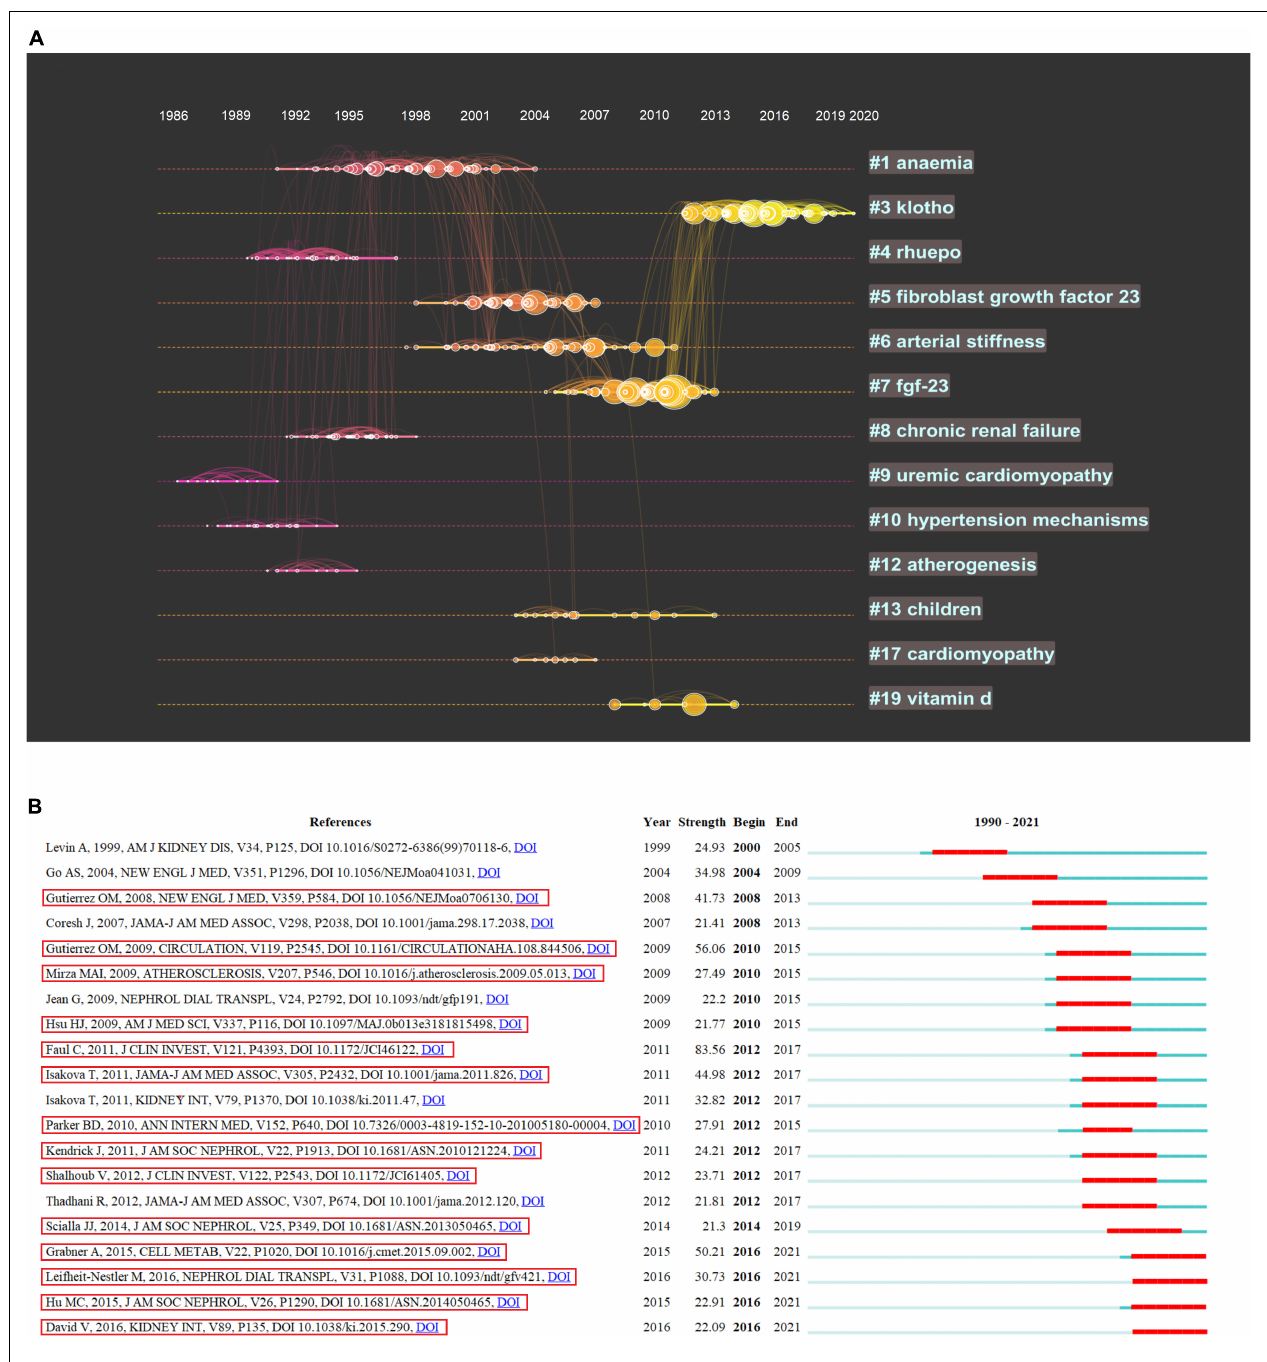
FIGURE 5 | Co-cited reference analysis. (A) Timeline distribution of 13 clusters with the higher K values. (B) The top 20 references with the higher citation bursts, references with the red box is directly associated with